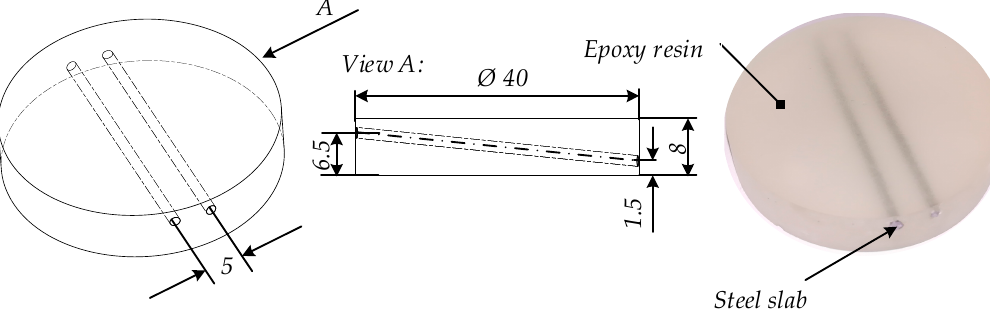
Figure 1. Principal sketch of the specimen. The specimen consists of steel rods that were embedded in epoxy resin. The cylindrical steel rods had a diameter of 1.5 mm.